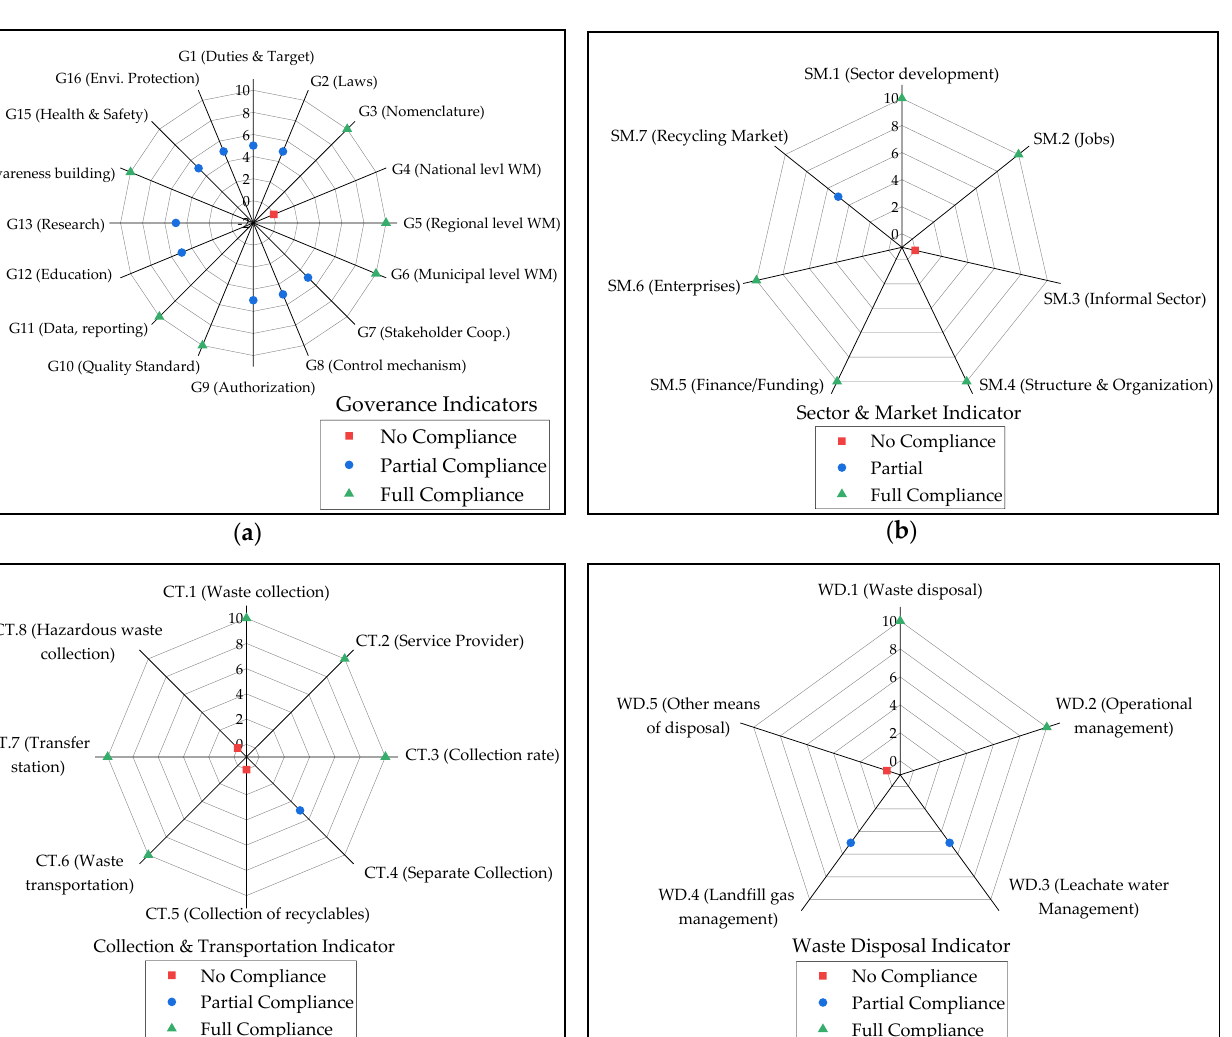
( f ) Figure 19. Performance assessment of waste sector: ( a ) Assessment of city against governance in- dictor; ( b ) Assessment of city against sector & market indicator; ( c ) Assessment of city against waste collection & transportation indictor; ( d ) Assessment of city against waste disposal indictor; ( e )